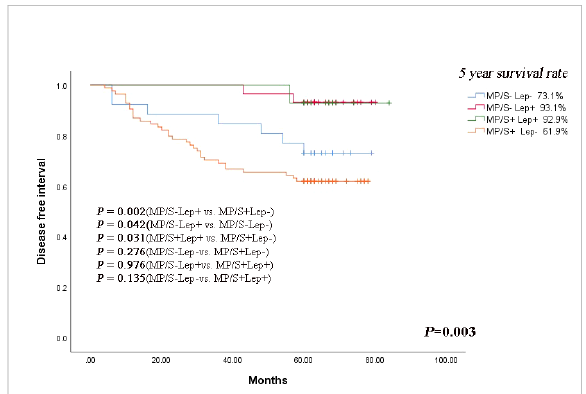
FIGURE 2 Kaplan-Meier curve of DFS according to lepidic, micropapillary/solid minor components in stage I lung adenocarcinoma patients. The comparison of DFS between 2 groups: MP/S − Lep + vs. MP/S + Lep − group ( P = 0.002), MP/S − Lep + vs. MP/S − Lep − group ( P =0.042), MP/ S + Lep + vs. MP/S + Lep − group ( P = 0.031), MP/S − Lep − vs. MP/S + Lep − group ( P = 0.276), MP/S − Lep + vs. MP/S + Lep + group ( P = 0.976), MP/ S - Lep - vs. MP/S + Lep + group ( P =